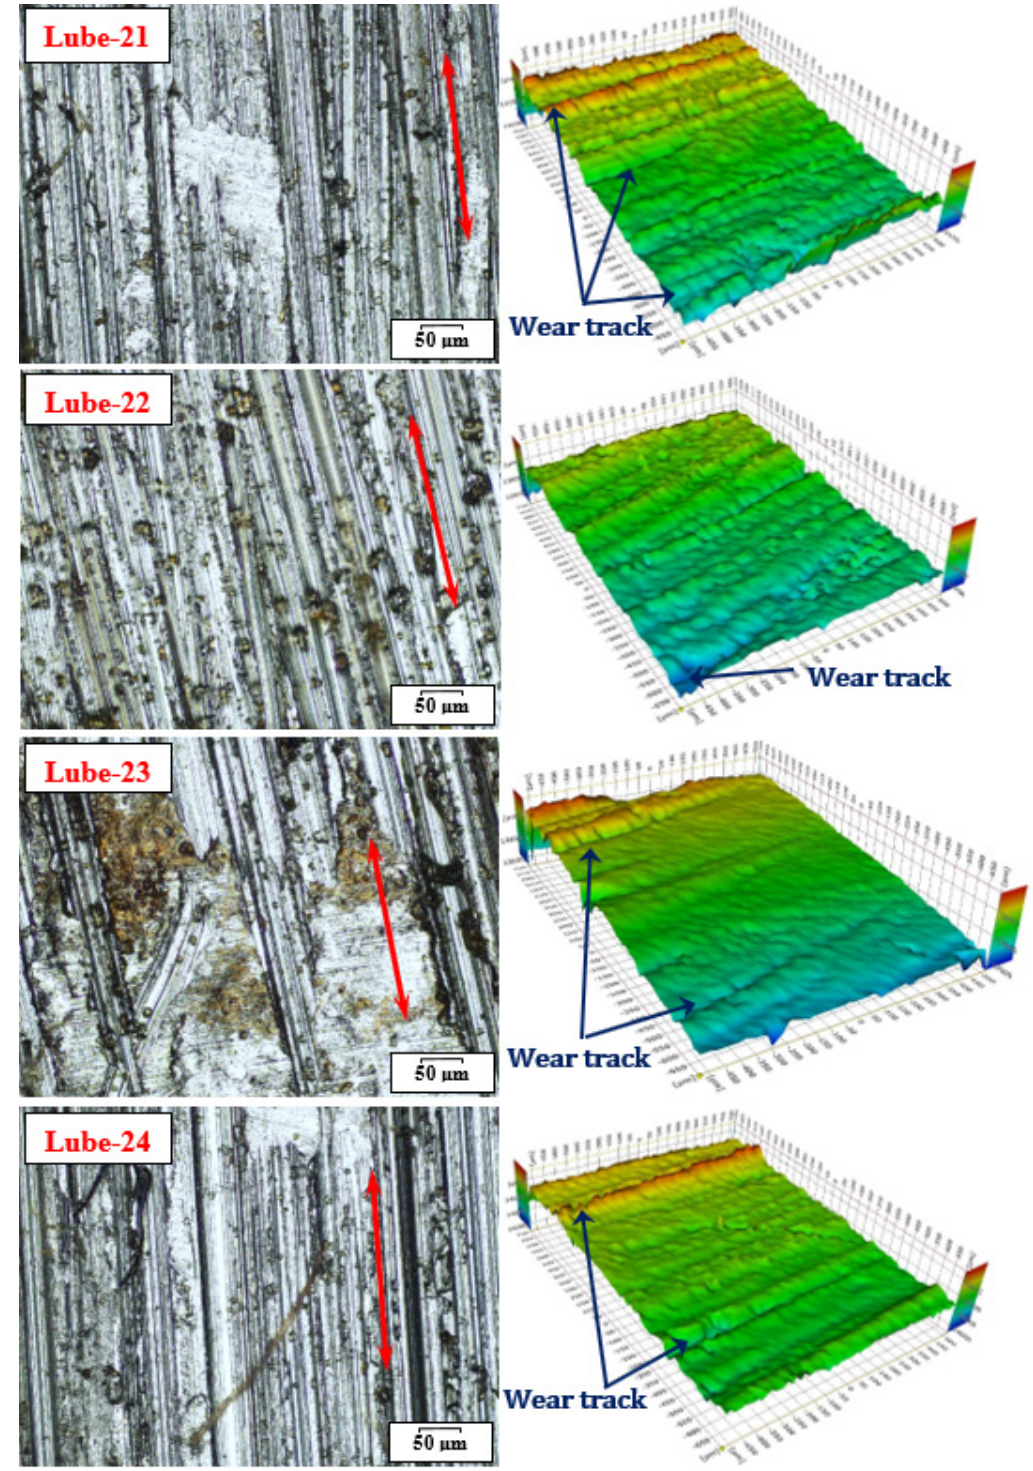
Figure 9. Micrographs of worn surface of samples (Lube-21, Lube-22, Lube-23, and Lube-24) with various loading contents of Al 2 O 3 NPs and 1.0 wt.% MWCNTs at different speeds and tempera- tures.